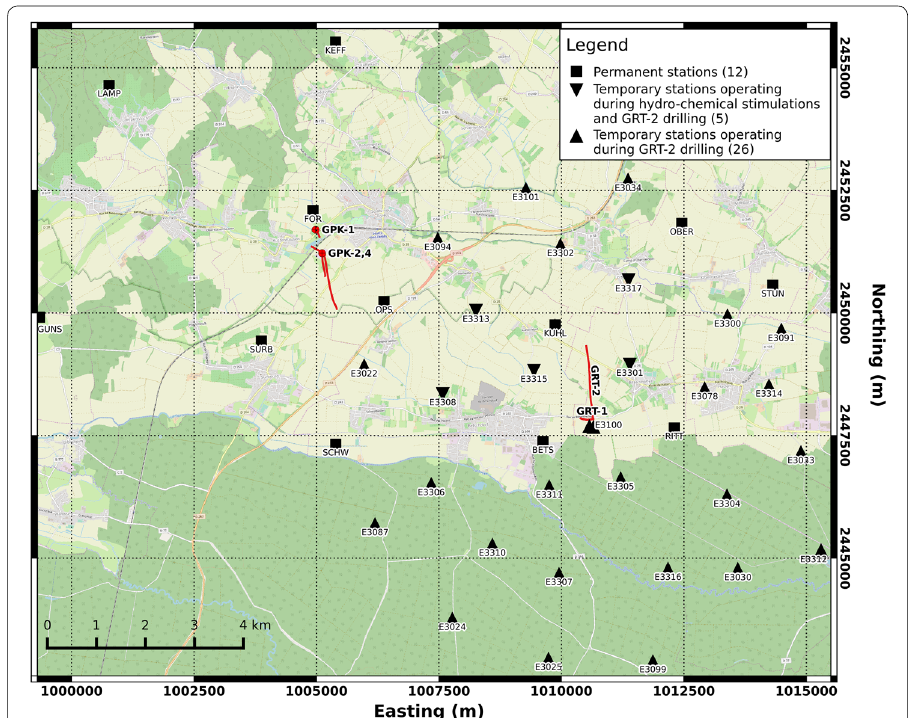
Fig. 5 Map of the location of the 43 seismological stations monitoring the Rittershoffen geothermal field. The 12 permanent stations are indicated with black squares; these were active during all development operations. The five temporary stations recording from the start of GRT-1 chemical and hydraulic stimulation are displayed as black inversed triangles. The 26 temporary stations added before GRT-2 drilling commenced are displayed as black triangles. The trajectories of the Rittershoffen and Soultz-sous-Forêts geothermal wells are also indicated in